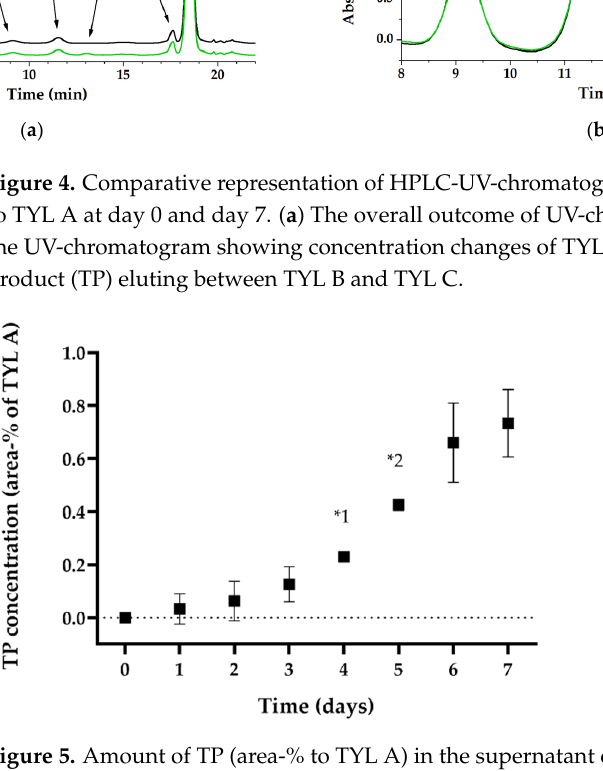
Figure 5. Amount of TP (area-% to TYL A) in the supernatant of pipes with 7-day-old biofilms with P. fluorescens (BA), results are shown with daily samplings starting 1 h after application (0) over 7 days. *1: one set with double sample collection ( n = 1, N = 2), *2: two sets with double sample collection ( n = 2, N =